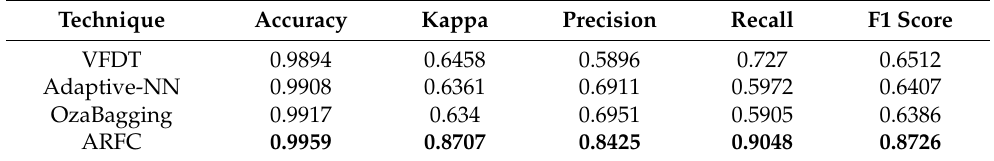
Table 4. Comparison of the performance between ARFC and three stream classifiers using five